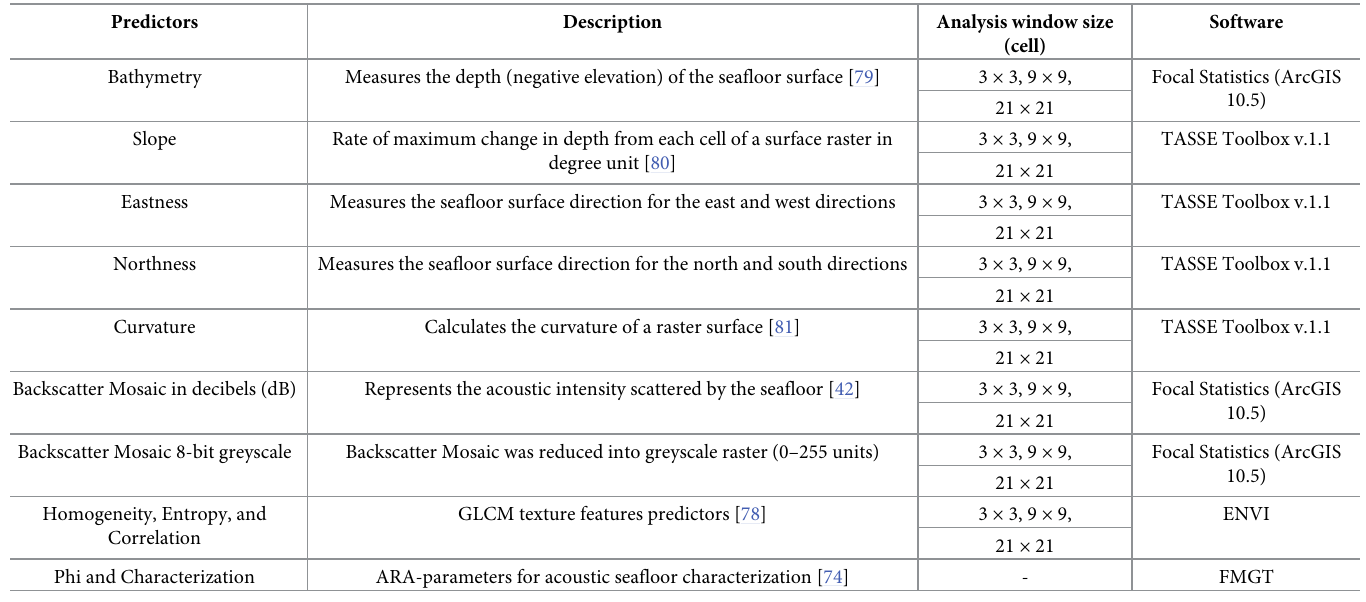
Table 1. Multiple analysis window sizes of bathymetric and backscatter predictors for seafloor morphology and sediment properties used in this study. Predictors